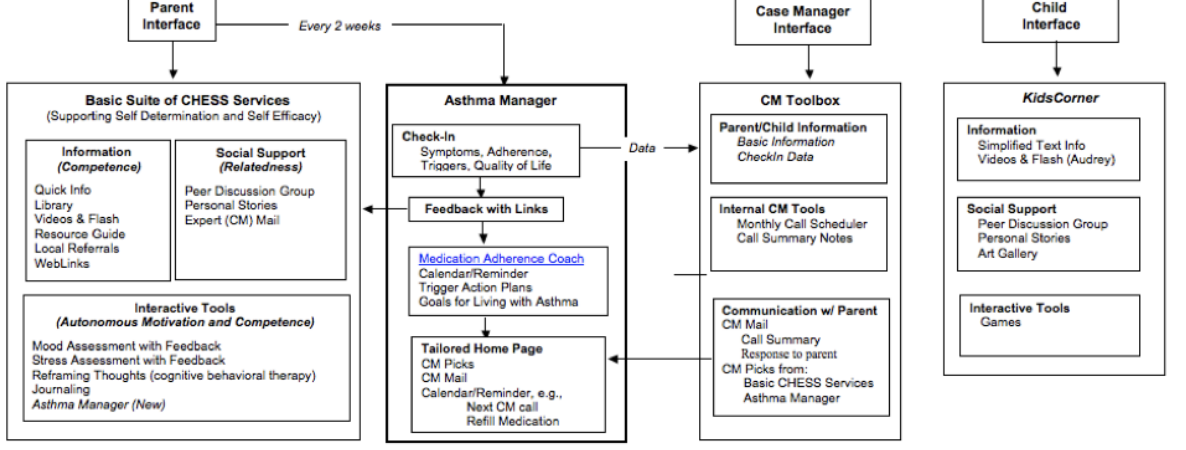
Figure 1. Comprehensive Health Enhancement Support System (CHESS) services for parent, case manager, and child. CM = case